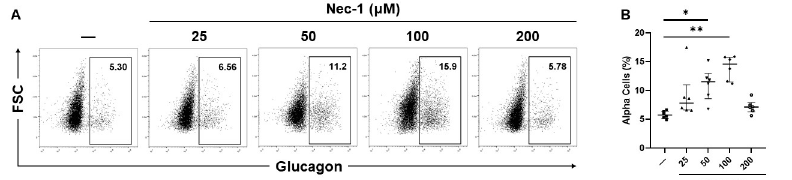
Fig 5. Alpha-cell composition of islets after 7 days of tissue culture in control media (—) or media supplemented with 4 different doses of necrostatin-1 (25, 50, 100, or 200 μ M of Nec-1) on day 3. 3000 islet equivalents were dissociated into single cells using Accutase, stained with 7-amino-actinomycin D (7-AAD) viability dye and allophycocyanin-conjugated anti-glucagon antibody, and analyzed by flow cytometry to quantify the proportion of alpha cells in islets. Glucagon-positive alpha cells were gated on 7-AAD-negative live cells. A) Representative flow cytometry plots of glucagon staining. B) Percentage of glucagon-positive alpha cells. n = 6 for each group. � p < .05. �� p < .01. Data are expressed as median and interquartile range.